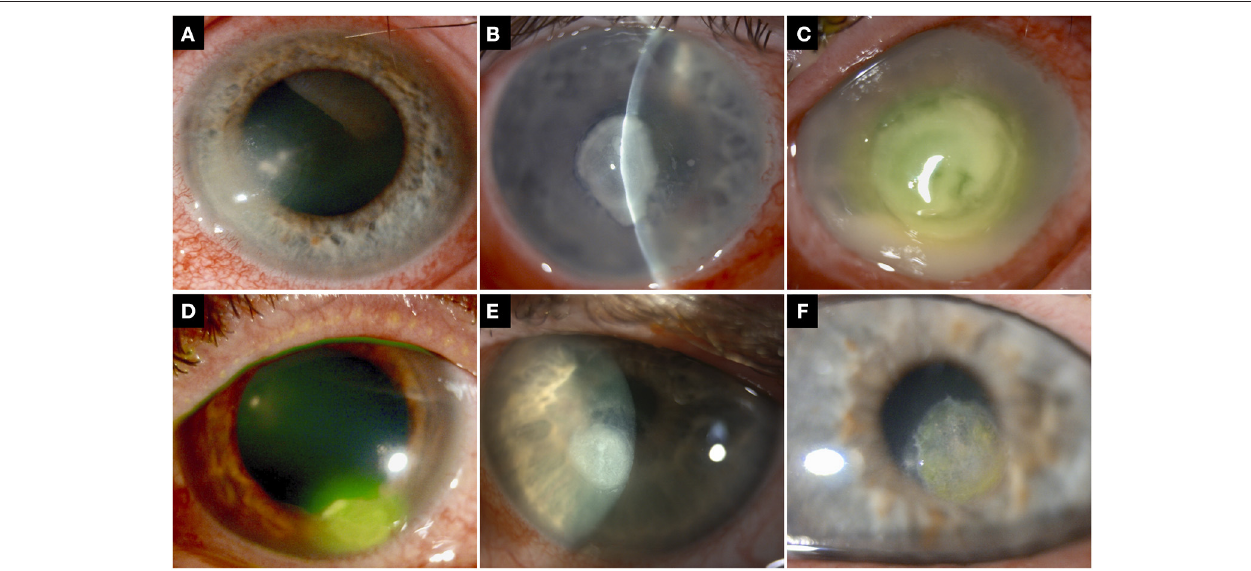
FIGURE 1 | (A–C) Examples of bacterial keratitis with varying severity, including (A) small infiltrate ( ≤ 3mm), (B) moderate infiltrate (3.1–6mm), and (C) large infiltrate ( > 6mm). (D–F) Examples of bacterial keratitis in different locations, including (D) peripheral, (E) paracentral, and (F) central location.